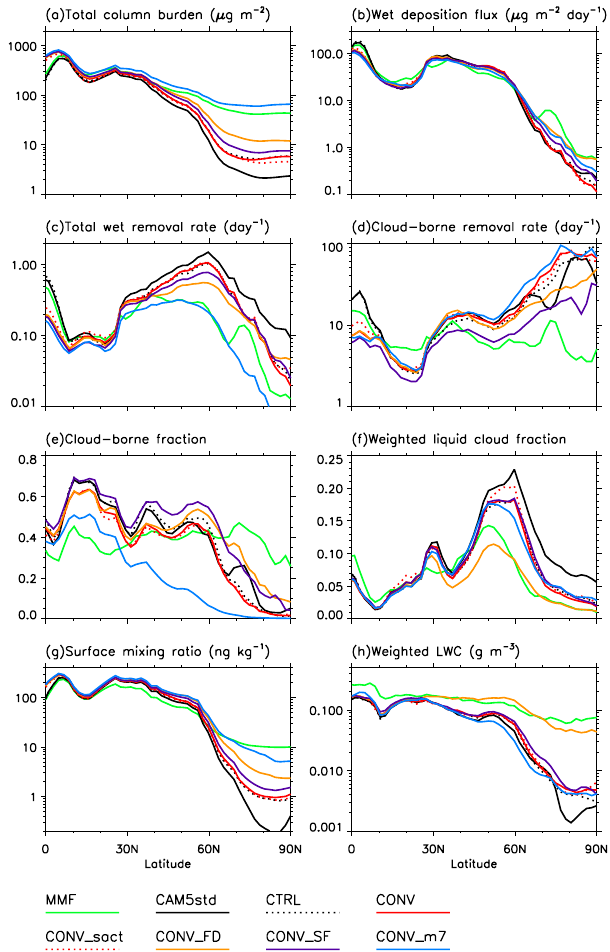
Fig. 2. Same as in Fig. 1 but including six more simulations listed in Table 1 and with a focus on the Northern